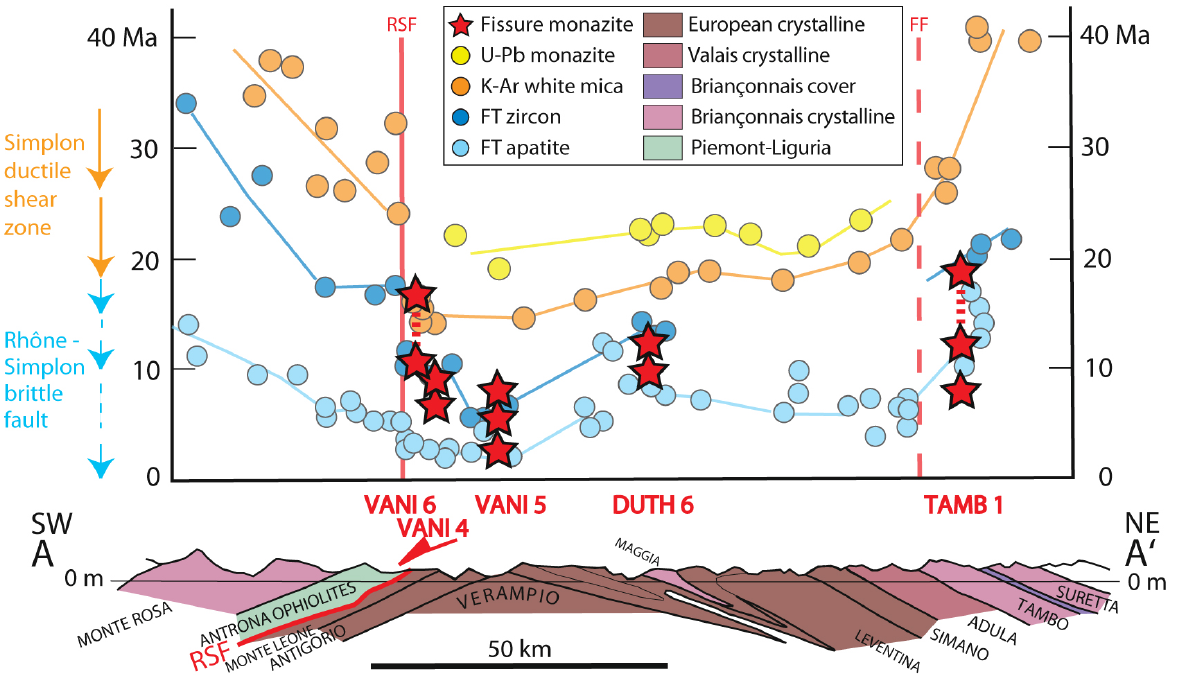
Figure 6. Figure modified from Steck et al. (2013), with cooling ages compiled by Steck and Hunziker (1994), and completed with data from Keller et al. (2005), Rahn (2005), Elfert et al. (2013) and Boston et al. (2017). Cleft monazite crystallization ages of samples from this study, located in the vicinity of the cross section (Figs. 1, 2), are shown for comparison. The red lines mark the Rhone-Simplon Fault (RSF) and Forcola Fault (FF, located south of the cross section). Sample VANI 6 is projected into the profile from some distance and into the foot wall of the RSF where cooling ages are similar to those around the sample location of VANI 6. Note that rock-forming monazite dates peak metamorphic conditions considerably higher than the (re)crystallization temperature of the hydrothermal cleft and fissure monazite-(Ce)